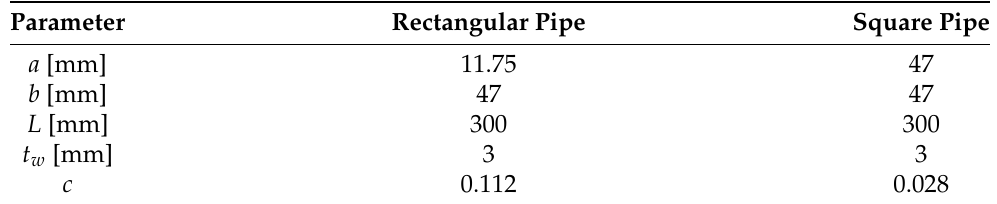
Figure 8. Sketch of the RELAP5 nodalization. Yellow arrows mark the fluid path. Magnetic field (B) is shown with a black vector. Table 6. Model geometry